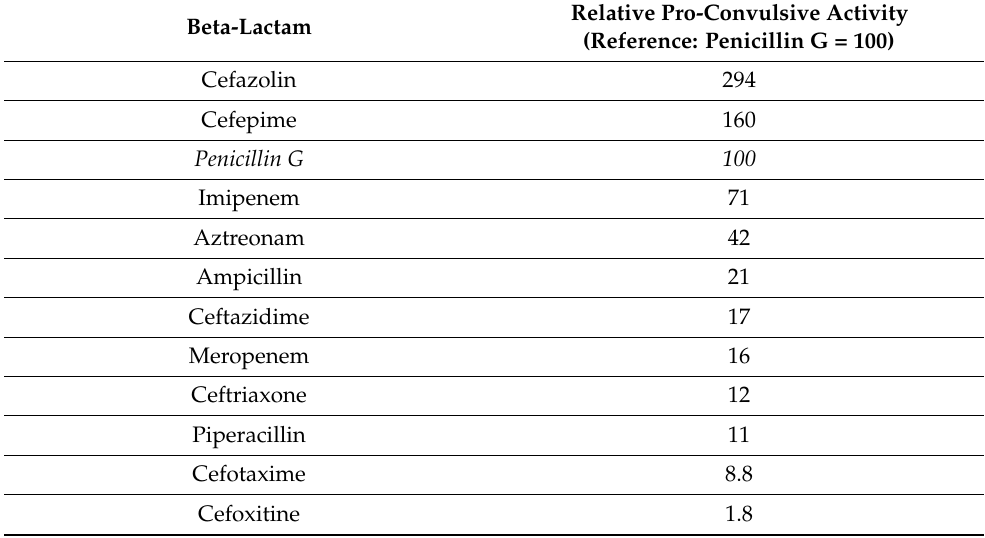
Table 1. Convulsing activity of beta-lactams compared to penicillin G